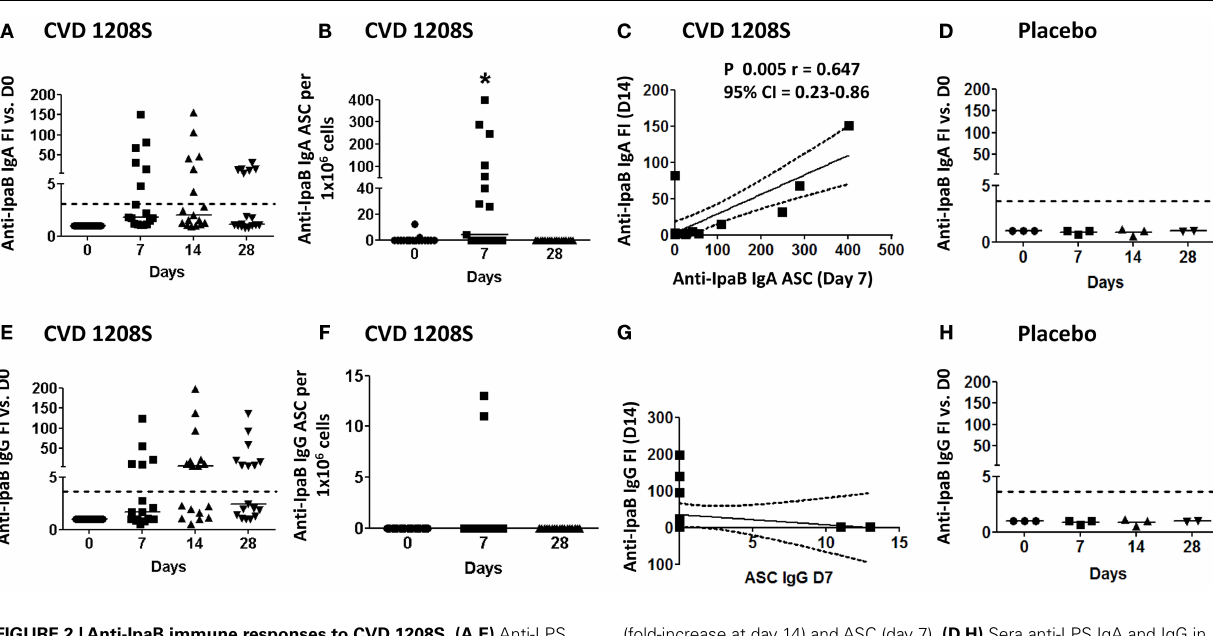
FIGURE 2 |Anti-IpaB immune responses to CVD 1208S . (A,E) Anti-LPS IgA and IgG serological responses before and at days 7, 14, and 28 after immunization. (B,F) ASC anti-LPS IgA and IgG (ELISpot) responses, respectively, before and at days 7 and 28 after immunization. (C,G) Spearman’s correlation between anti-LPS IgA and IgG antibody titers